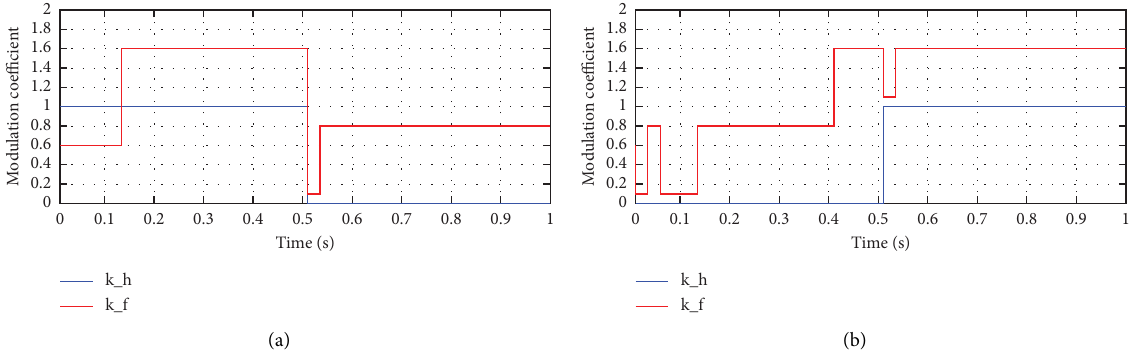
Figure 25: Grid current (a) and its THD (b).